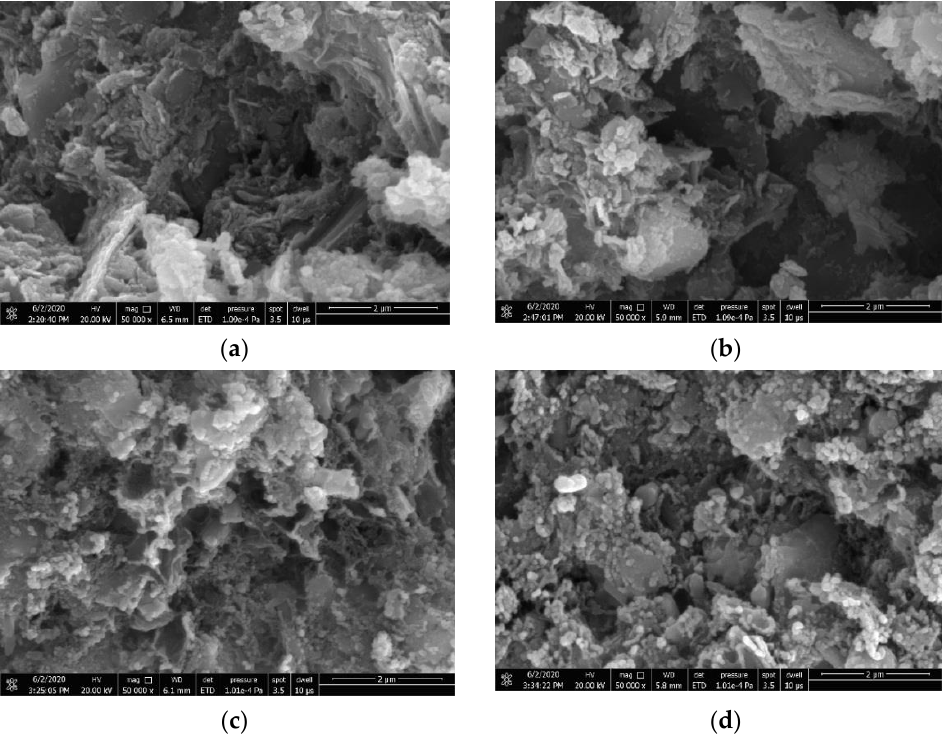
Figure 2. SEM images of ceramsite at different temperatures ( a ) 105 °C; ( b ) 350 °C; ( c ) 650 °C; ( d ) 950 °C.